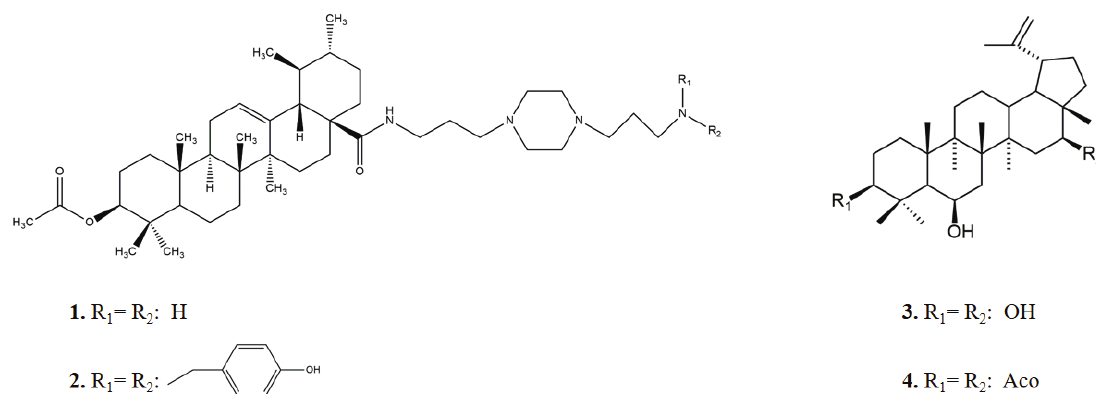
FIGURE 1 – Compounds previously tested: 1. N -{3-[4-(3-(Bis(4-hydroxybenzyl)amino)propyl)piperazinyl]propyl}-3-O- acetylursolamide; 2. N -{3-[4-(3-aminopropyl)piperazinyl]propyl}-3-acetylbetulinamide; 3. 3β,6β,16β-trihydroxylup-20(29)-ene; 4. 3β,6β,16β-trihydroxylup-20(29)-ene derivative, with 2 acetyl